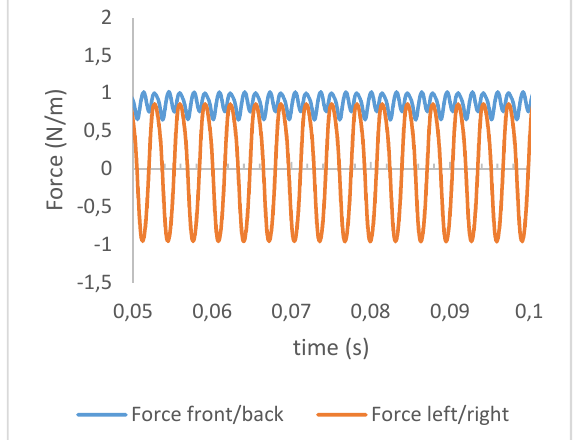
Fig. 12. Forces acting on the suppor element surface in flow direction and perpendiculatr to it for a flow velocity of 36 km/h.